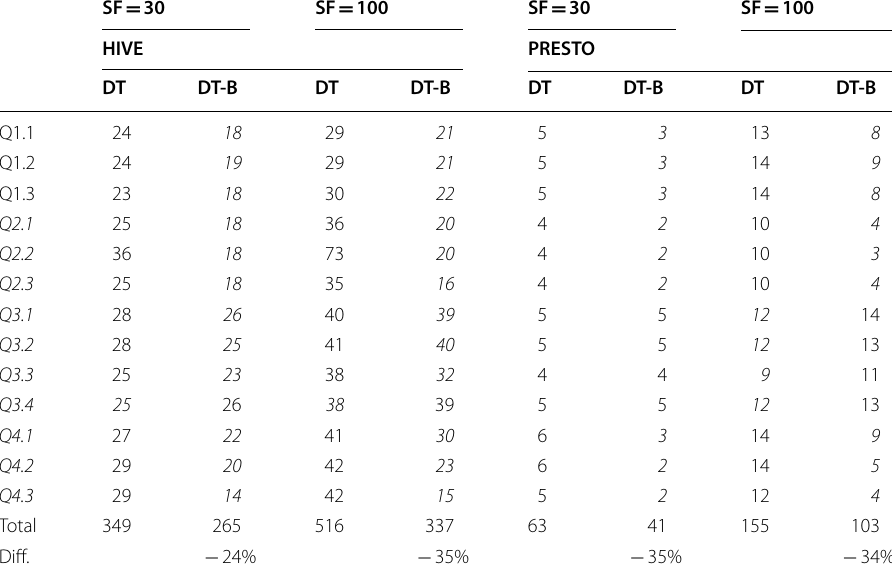
Italic values indicate the fastest processing time by query, workload, tool and data model, also pointing the queries that include the sorted attribute in the “ group by ” and “ order by ”